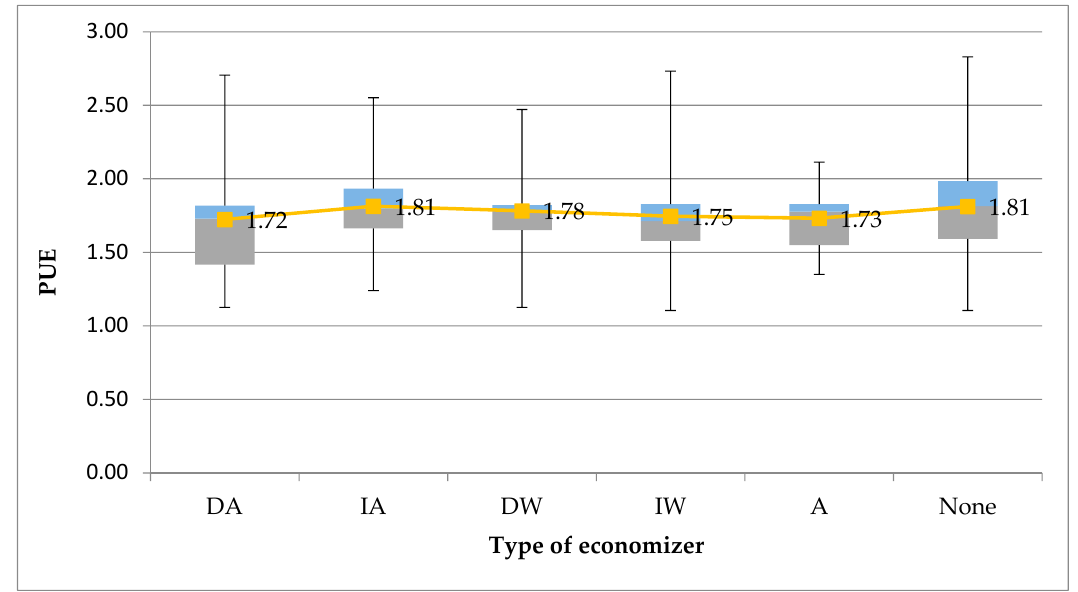
Figure 8. PUE range by type of free cooling technology (Direct Air = DA, Indirect Air = IA, Direct Water = DW, Indirect Water = IW, Adsorption = A).